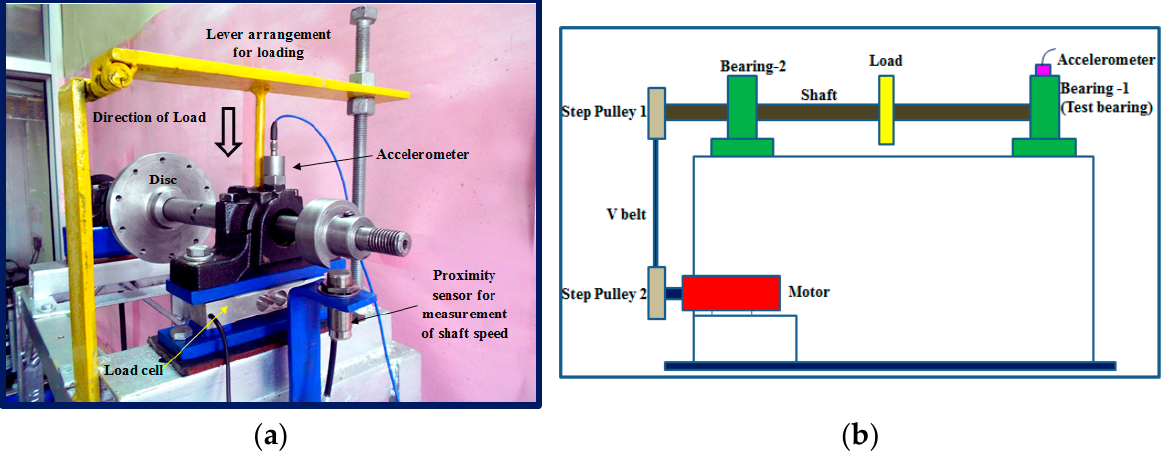
Figure 13. Test rig for simulations of roller-bearing faults, ( a ) photograph of a typical view of the test rig, ( b ) schematic of test rig for measuring roller fault width [27–29].